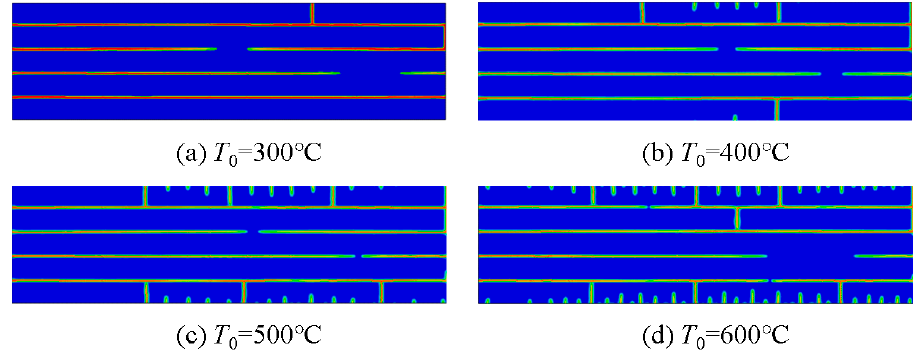
Figure 12. Numerical simulation results of thermal shock for layered ceramics with layer thickness ratio R = 5 at different initial temperatures.